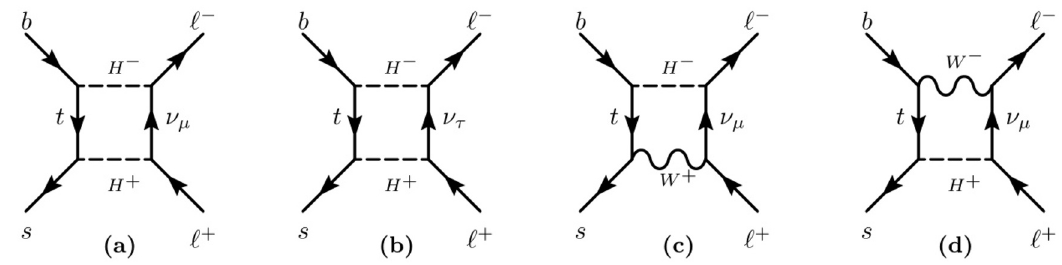
Figure 2 . Box diagrams for b → s‘ + ‘ −